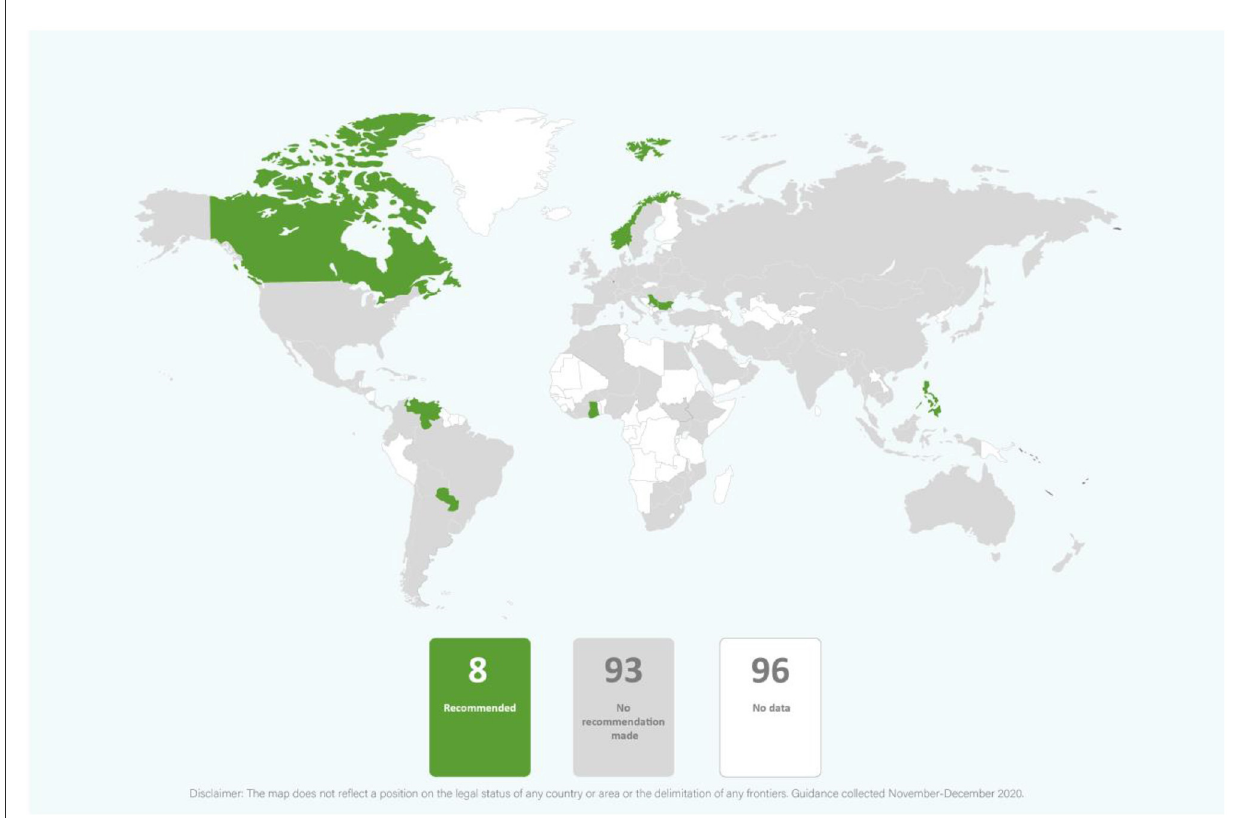
FIGURE8 Global distribution of recommendations on psychological support for infants of mothers with COVID-19 (data from 101 countries).